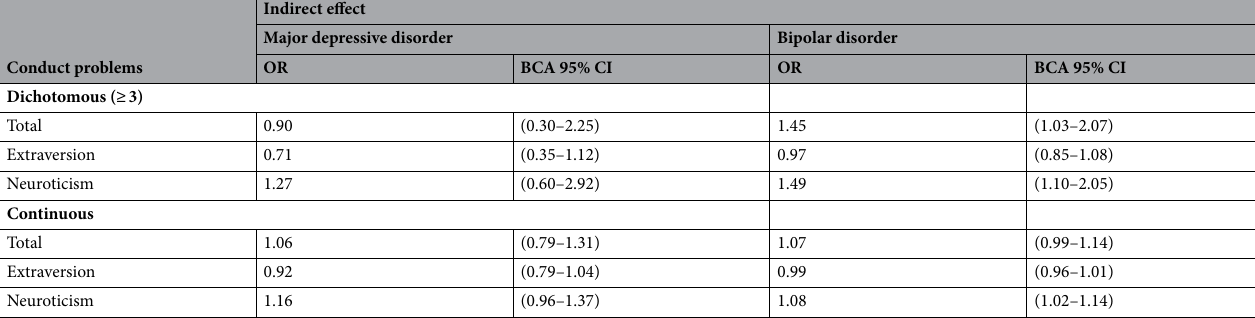
Table 4. Indirect effects of conduct problems on mood disorders mediated by extraversion and neuroticism. BCA 95% CI bias corrected and accelerated 95% confidence